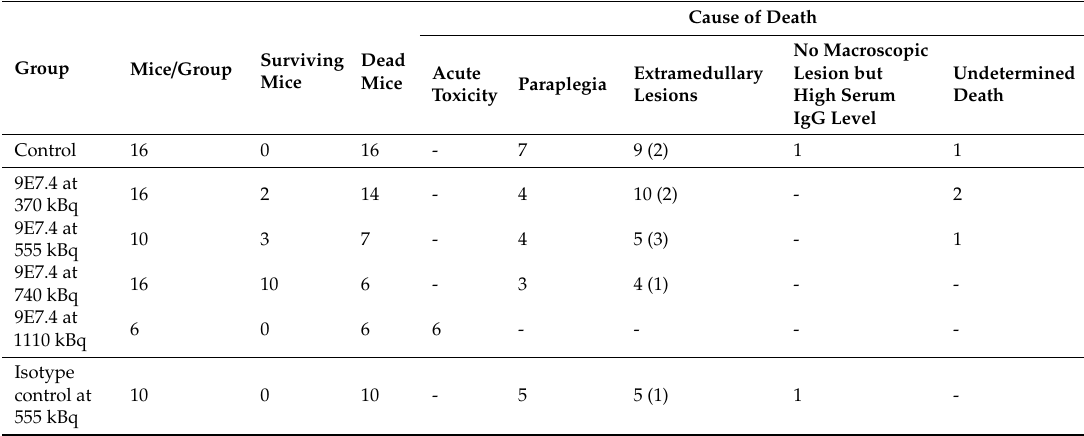
Table 1. Summary of the survival study and cause of death. Numbers in brackets indicate paraplegic mice with extramedullary lesions. Data were issued from 2 independent experiments.